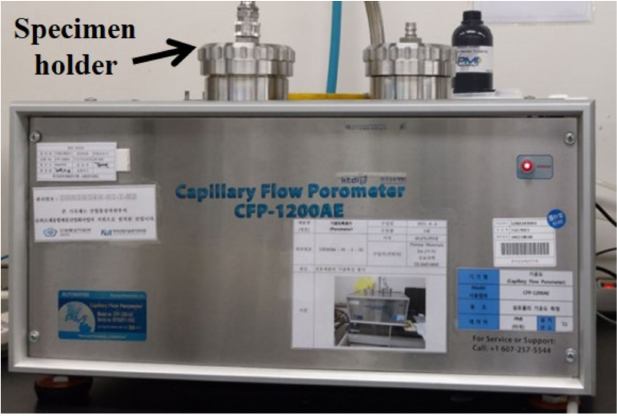
Figure 1. Capillary flow porometer machine. A fabric specimen 47 mm in diameter was placed in the specimen holder shown in Figure 1. The specimen holder was closed, and slight gas pressure was applied to eliminate the possible liquid backflow. The gas pressure was increased slowly. Finally, the lowest pressure at which a steady stream of bubbles rises from the central area of the liquid reservoir was recorded. The maximum pore diameter (D) was calculated using Equation (1) from the median value of the graph between the airflow and pressure.